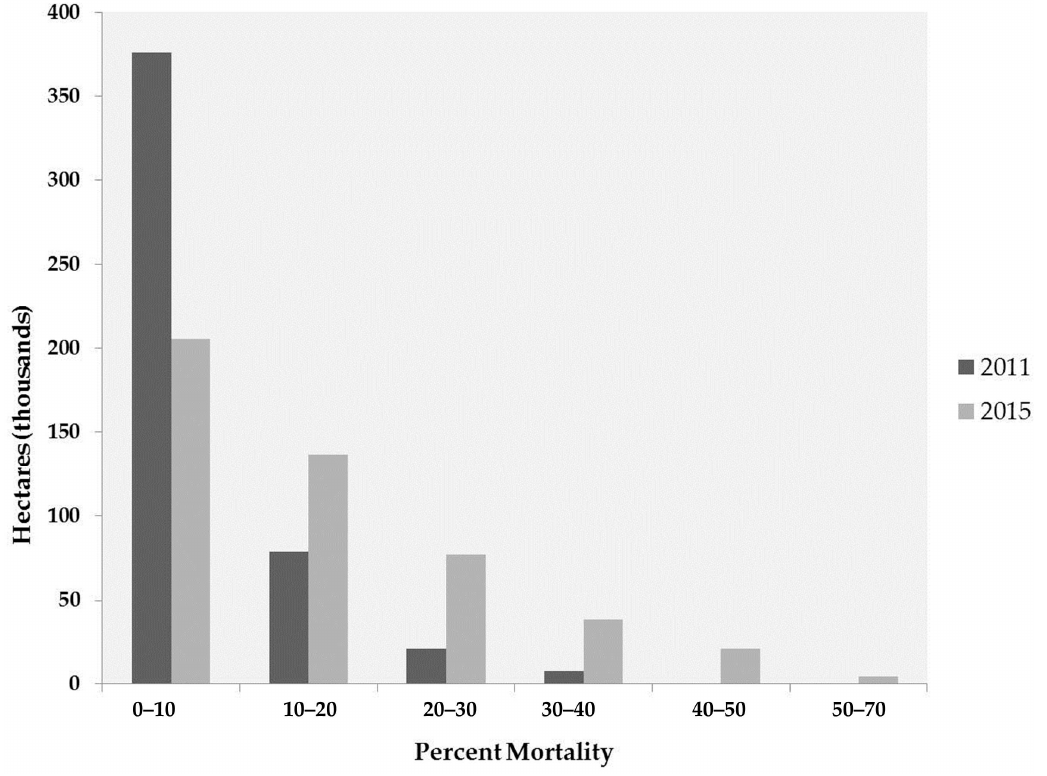
Figure 5. Relative area of percent mortality as the outbreak progressed between 2011 and 2015. Mortality intensity increased as the outbreak progressed.